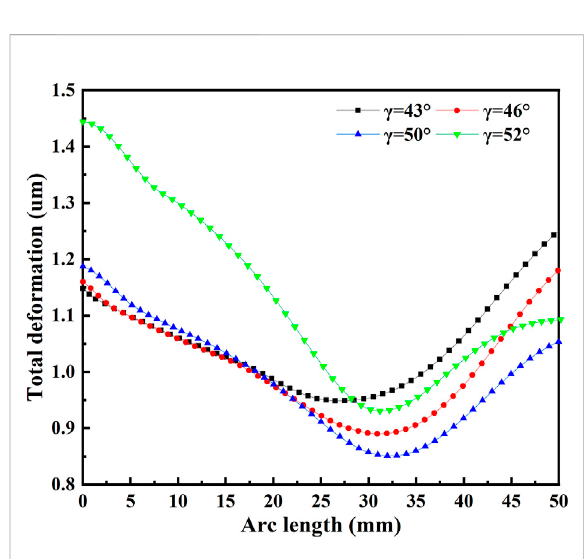
FIGURE 13 Deformation of tooth heads with different correction angles under pressure load.